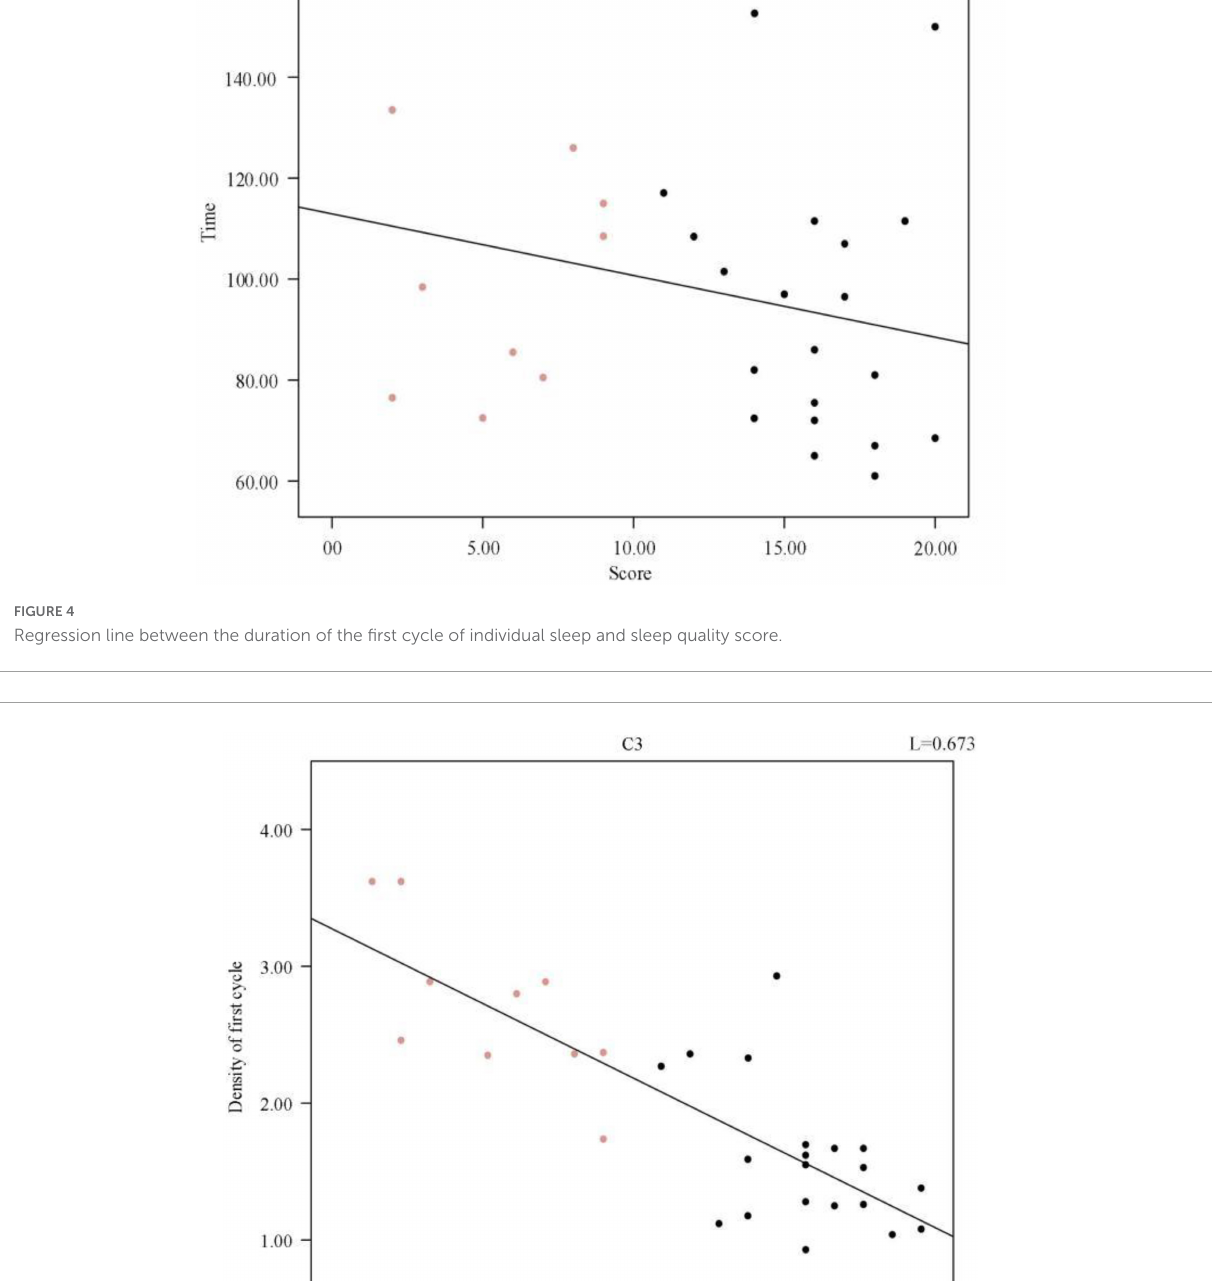
above 60 µ V. It can be seen from Figure 8 that the amplitude of the spindle was mostly distributed between 20 and 40 µ V in both the sleep-disordered and normal subjects, with 56.1% of the spindles distributed between 20 and 40 µ V in the sleep-disordered